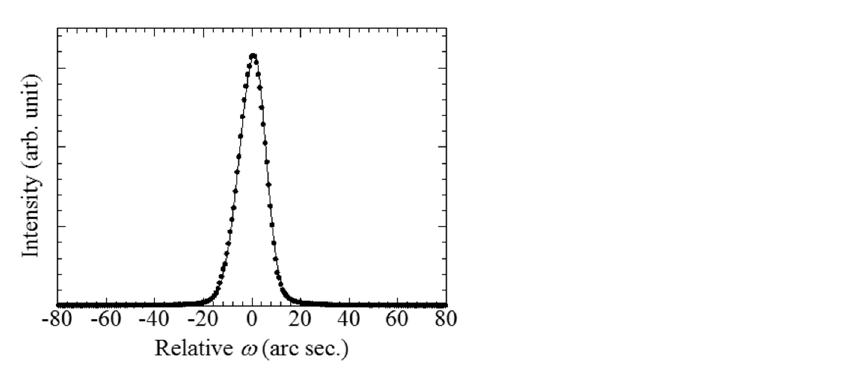
Figure 1. High-resolution rocking curve scan result around 00 , 018 diffraction peak of SCAM single crystal. The measurement results (dots) are fitted by pseudo-Voigt function (solid line).